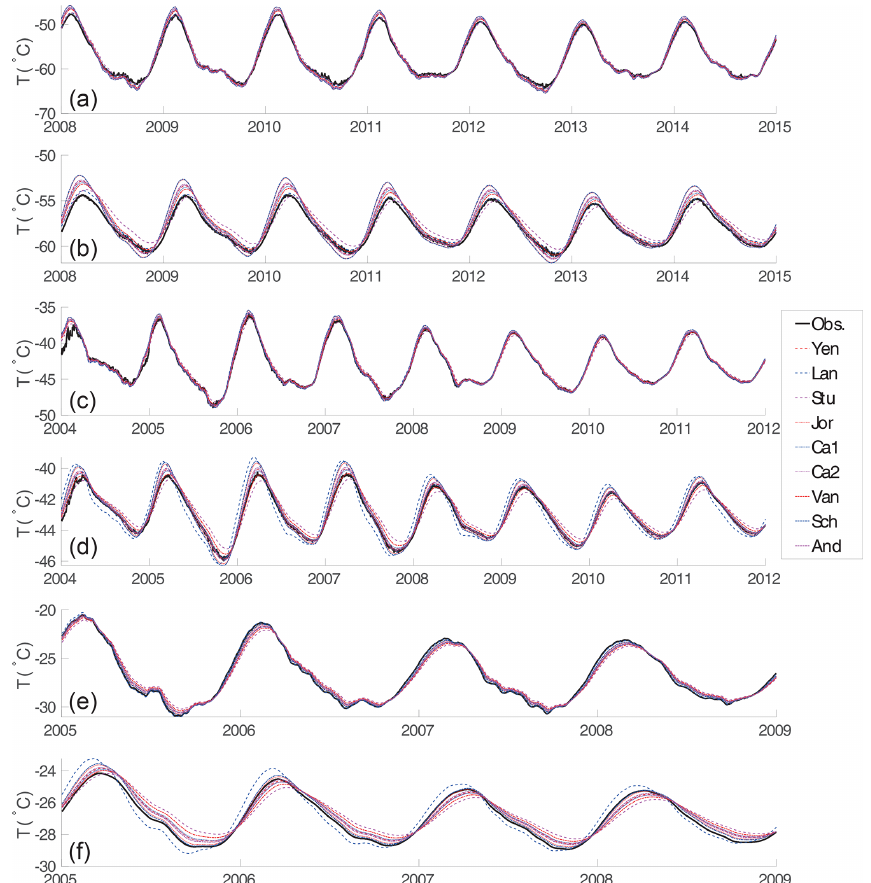
Figure 2. Comparison of observed and modeled temperatures using different density-dependent conductivity relationships at depths of 1m (a, c, e) and 3m (b, d, f) at Dome A (a, b) , Eagle (c, d) , and LGB69 (e, f) .